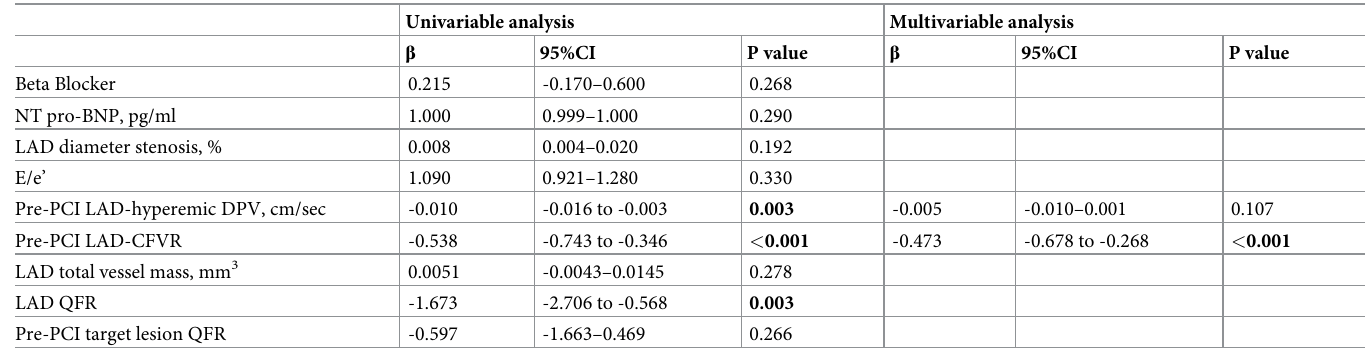
Table 2. Linear regression analysis for the change in LAD-CFVR after non-LAD PCI.